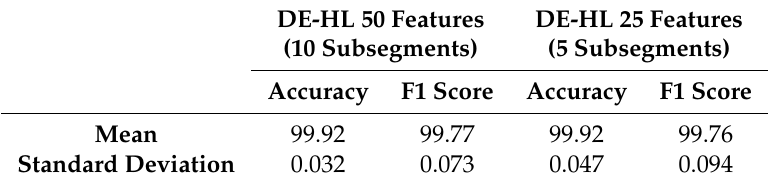
Table 3. Comparison test to select the number of subsegments. Abbreviations: HL: combination of High-pass and low-pass filtering; DE: differential